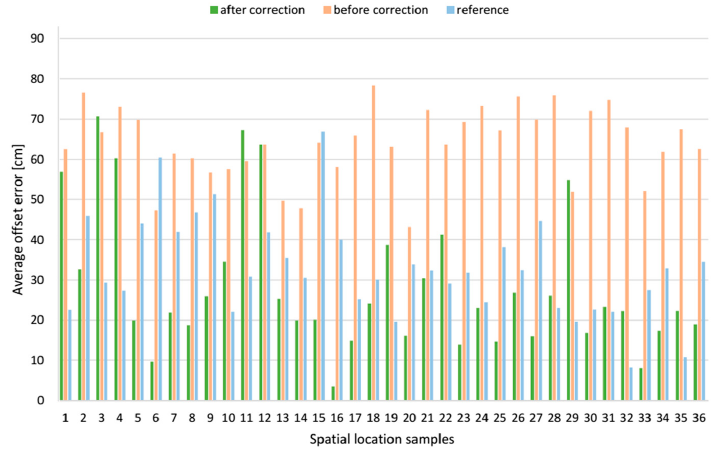
Figure 23. Comparative bar plots of the average resultant offset error for AD pair.